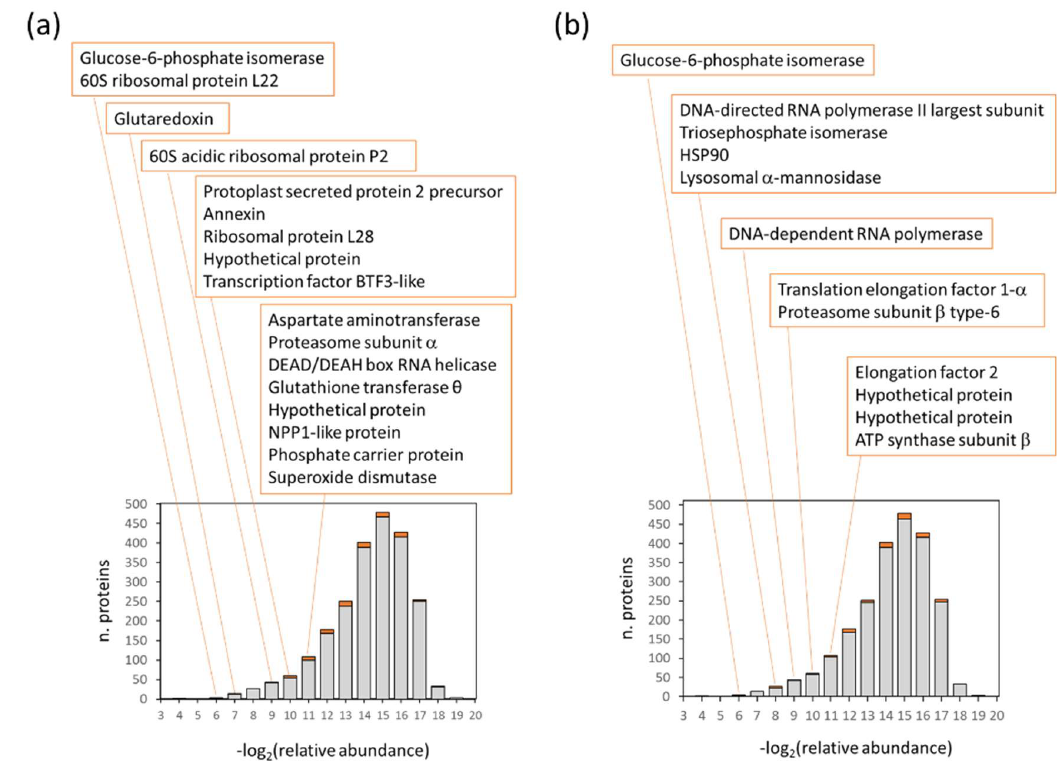
Figure 8. Relative abundance distribution of 2282 P. infestans proteins quantified in mycelium and highlighted proteins (orange) found in inoculated detached leaves ( a ) and in the field-grown plants ( b ). Proteins representing 1.6–0.05% of total protein abundance in mycelium are listed. Int. J. Mol. Sci. 2020 , 21 , x FOR PEER REVIEW